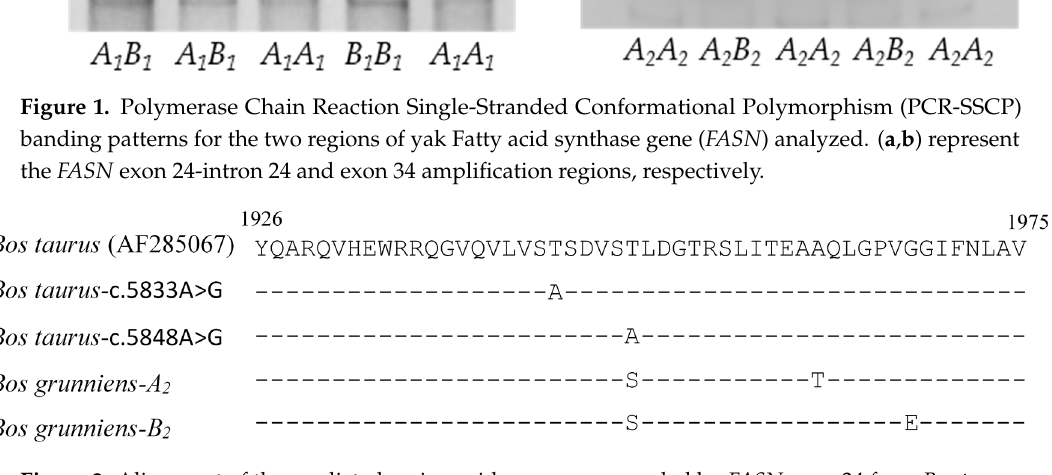
Figure 2. Alignment of the predicted amino acid sequences encoded by FASN exon 34 from Bos taurus and Bos grunniens . Amino acid sequences are presented in one letter code and slashes indicate sequences identical to the top sequence. Numbers above the sequences represent the amino acid positions.